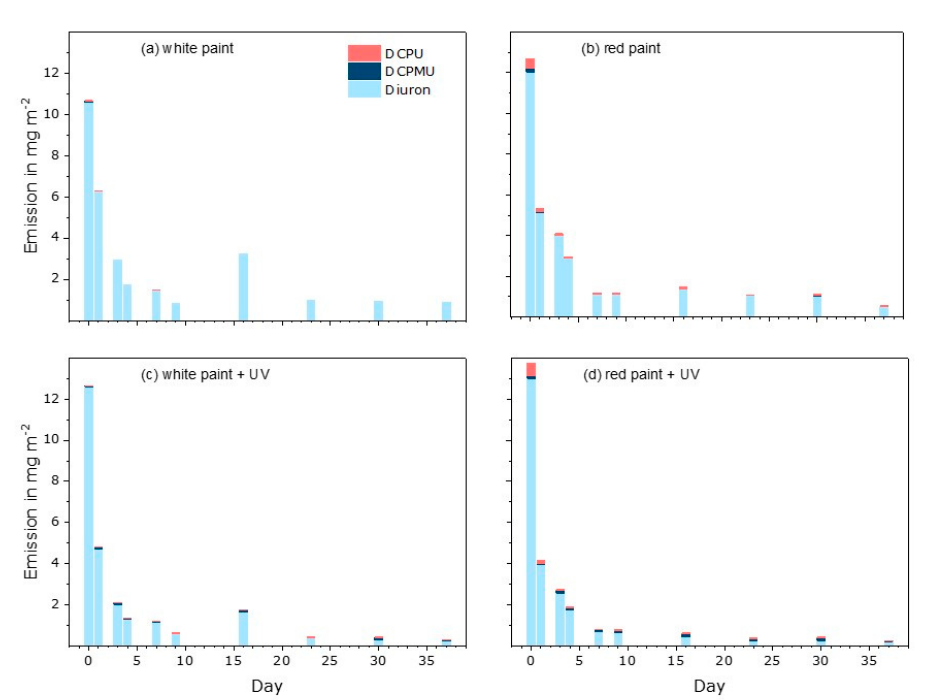
Figure 4. Emission of diuron and transformation products during immersion cycles. Upper row: test specimens were kept in a dark room at 21 ± 2 °C and 60 ± 5% relative humidity between the immersion cycles; lower row: test specimens were exposed to UV radiation at 40 °C between the immersion cycles. Each column represents a single experiment. The first data points for the two experiments on either white or red paint can be considered independent repetitions and indicate the variability of results between test specimens.